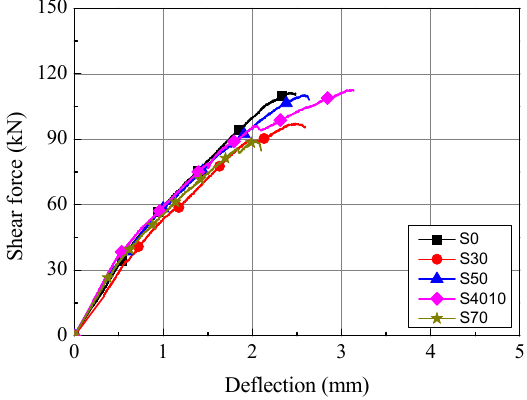
Figure 9. Shear force-deflection relationships of S series.